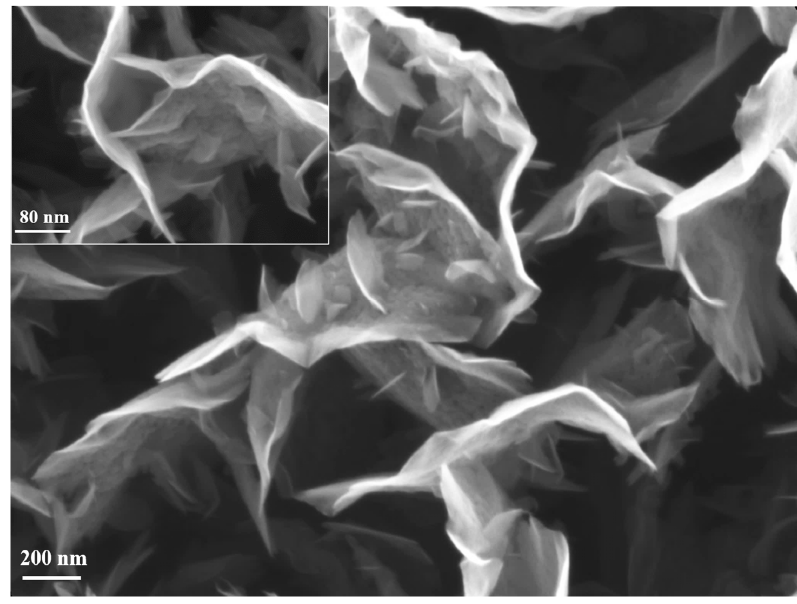
Figure 6. CNW control sample, after synthesis using PECVD method.